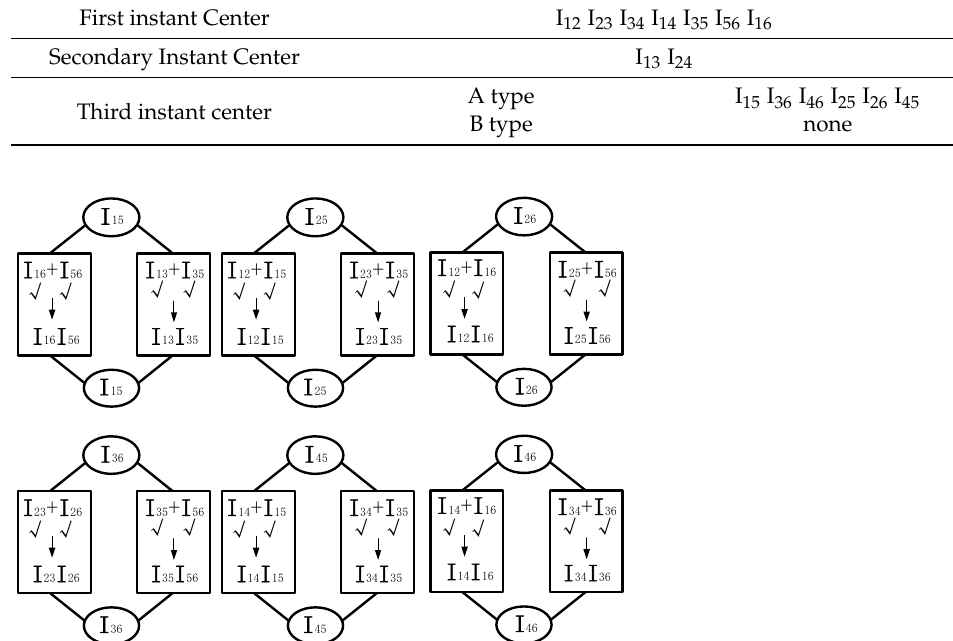
Table 1. Instant centers of the Stephenson linkage.